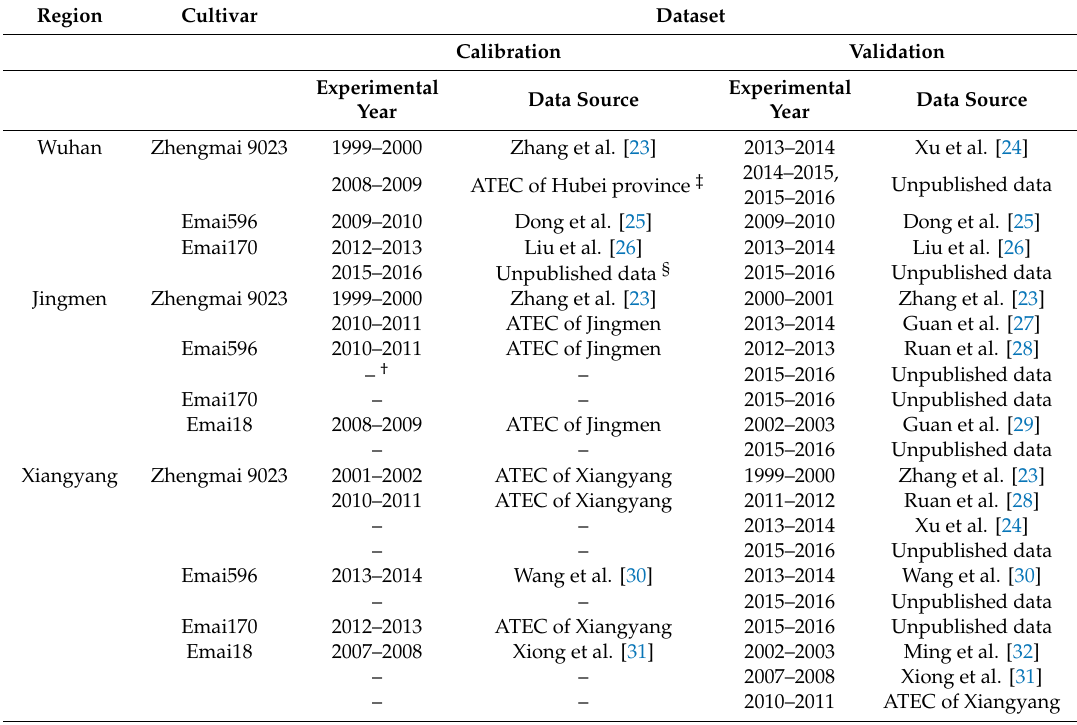
Table 1. Wheat varieties and sources of experimental data for agricultural production system simulator (APSIM)-wheat model calibration and validation in Hubei